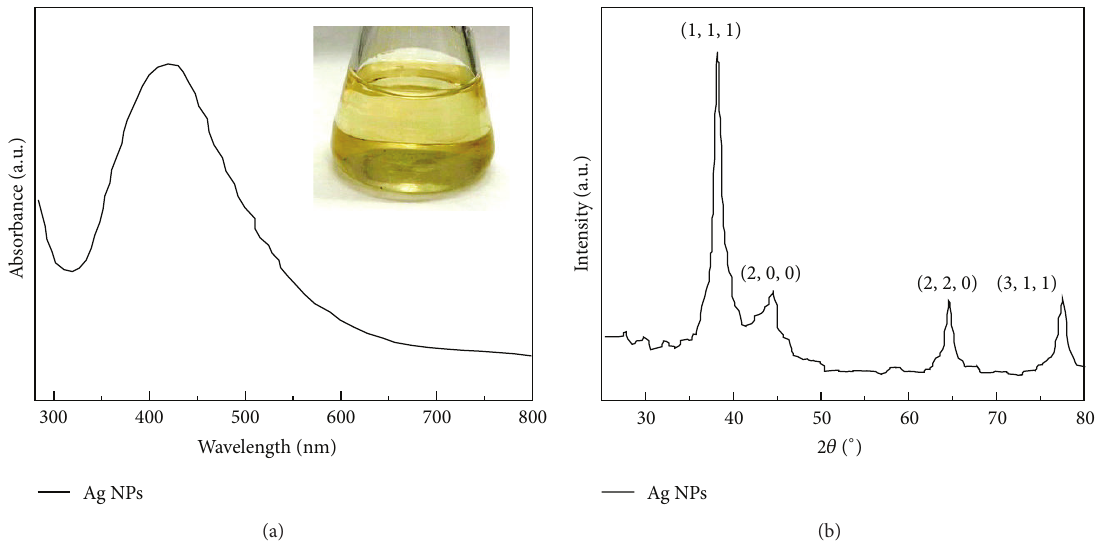
Figure 3: UV-Vis spectrum (a) and X-ray powder diffraction pattern, smoothed with a Savitzky-Golay 10pt. window filter (b).